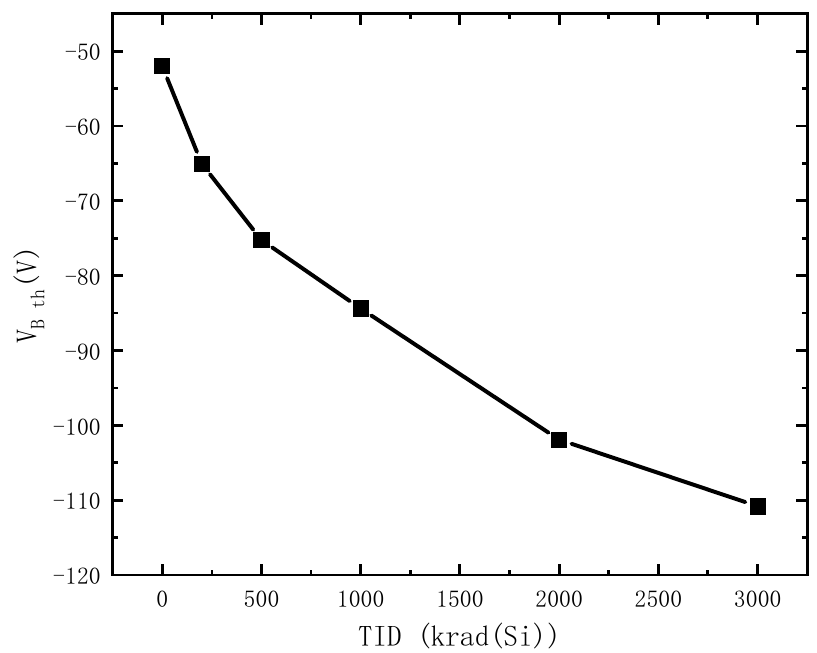
Figure 7. Threshold voltage of the back-gate transistor after irradiation. Figure 8 shows the coupling coefficient between the back-gate transistor and the front-gate transistor. The device coupling coefficient is almost linear, indicating that